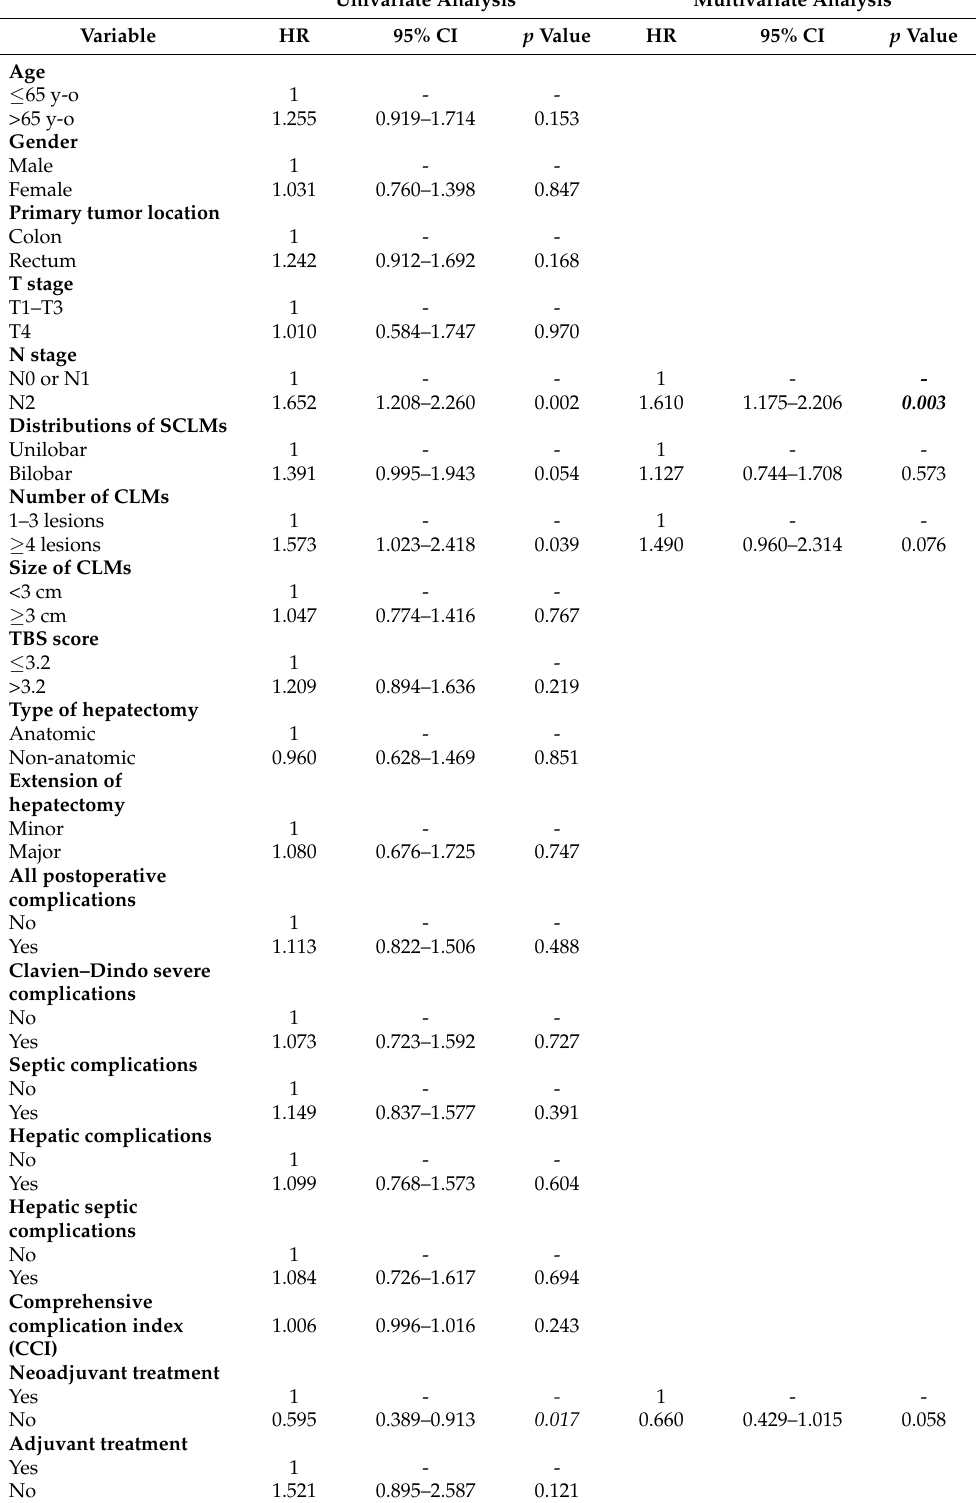
Table 4. Univariate and multivariate analysis of prognostic factors for OS. Univariate Analysis Multivariate